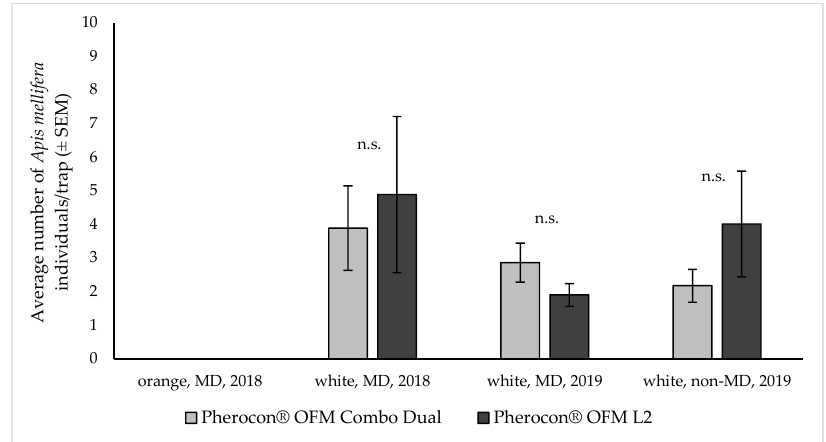
Figure 1. Honeybees ( Apis mellifera L.) captured by either orange or white colored delta traps baited with lures used to monitor Grapholita molesta flight in peach and nectarine orchards. Mean (± SEM) total honeybee captures over the trial period (six to eight weeks) in traps baited with Pherocon ® OFM Combo Dual and Pherocon ® OFM L 2 (Trécé Inc.). Trials were performed in orchards treated or not treated with mating disruption (MD and non-MD, respectively): in 2018 n = 13 under MD; in 2019 n = 11 under MD and n = 9 in non-MD orchards. Statistical analysis performed with a Generalized Linear Mixed Models using Template Model Builder (glmmTMB), n.s. = di ff erences not